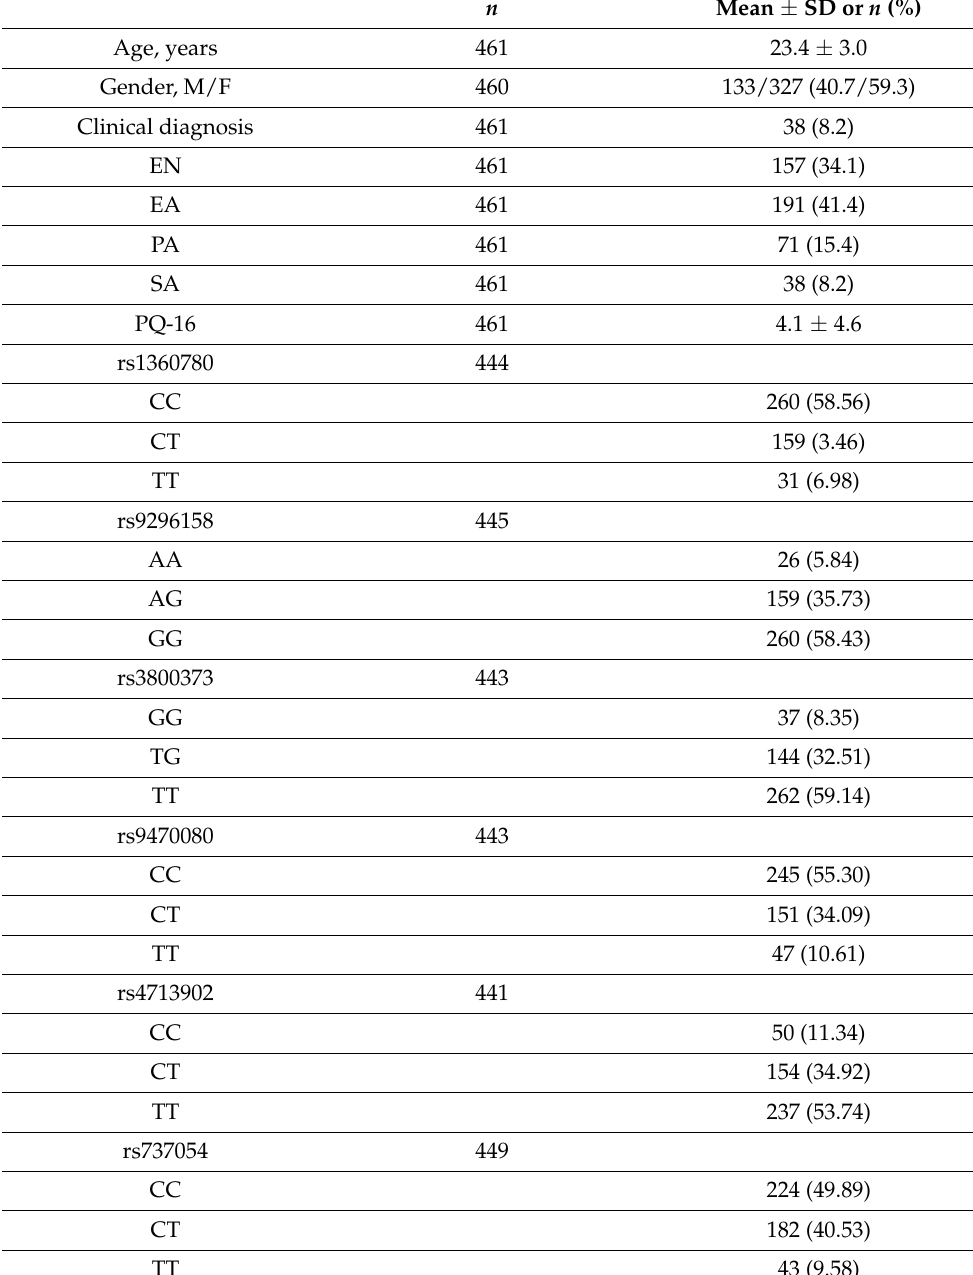
Table 1. General characteristics of the sample.